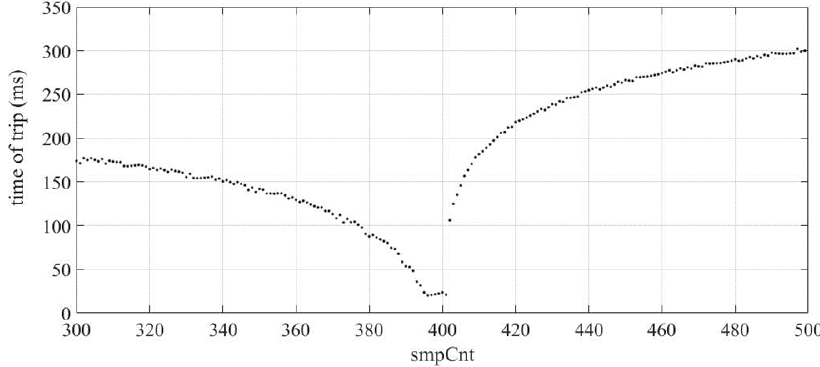
Figure 16. Tripping time results ANSI 50 — smpCnt manipulation of SV packets.